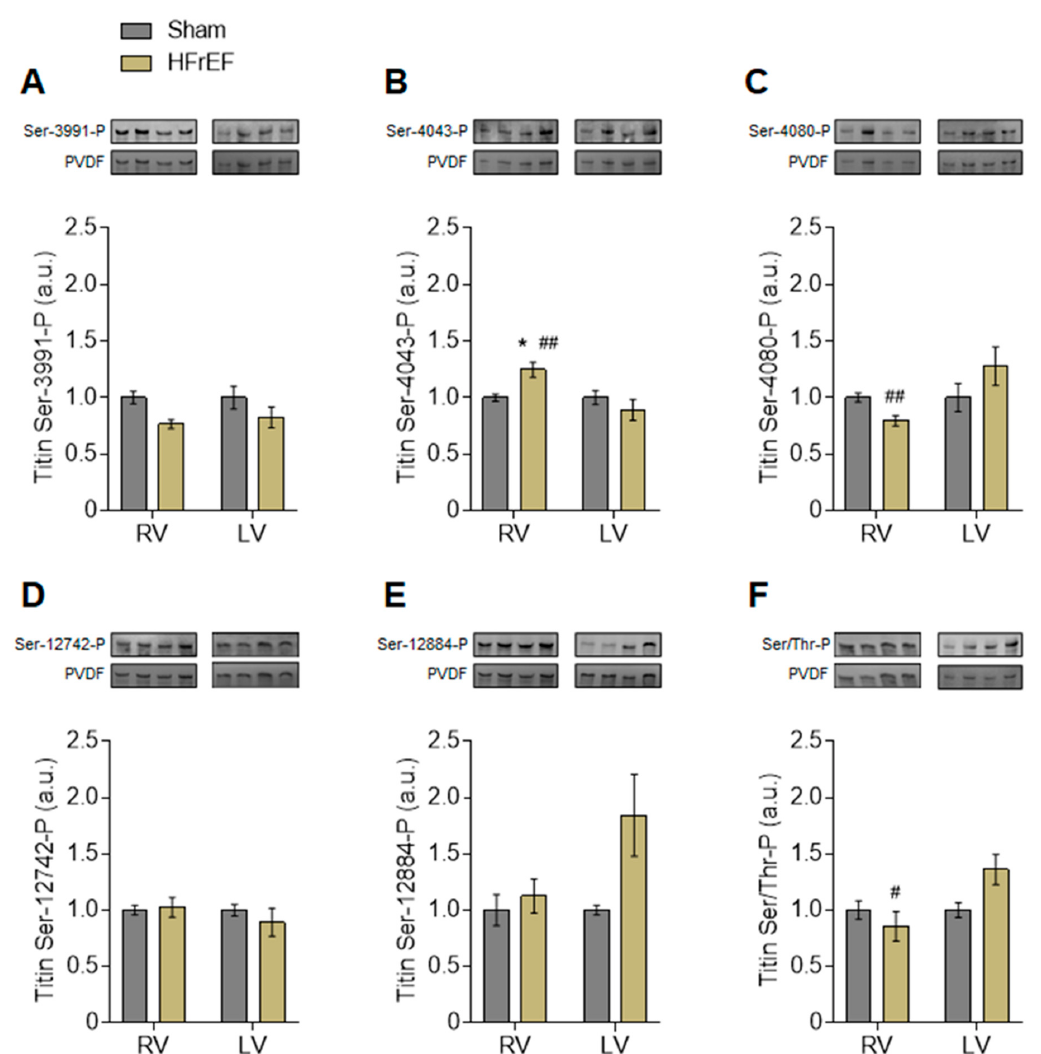
Figure 4. Interventricular differences of titin phosphorylation in the post-ischemic rat heart. Titin phosphorylation (P) levels are shown within the N2Bus domain at serine (Ser)-3991 ( A ), Ser-4043 ( B ) and Ser-4080 ( C ), as well as within the PEVK region at Ser-12742 ( D ) and Ser-12884 ( E ). Phosphorylation at Ser and threonine (Thr) residues is given as total titin phosphorylation ( F ). Insets : Representative images show Western immunoblots of duplicates using P-site-specific anti-titin antibodies (top) and corresponding PVDF stains (bottom) at a molecular weight of ~3.0 MDa (titin N2B isoform). Data are shown as mean ± SEM; n = 6–15 sample/3–5 heart/group. * p < 0.05 HFrEF vs. Sham (same ventricle); # p < 0.05, ## p < 0.01 RV vs. LV (same group).